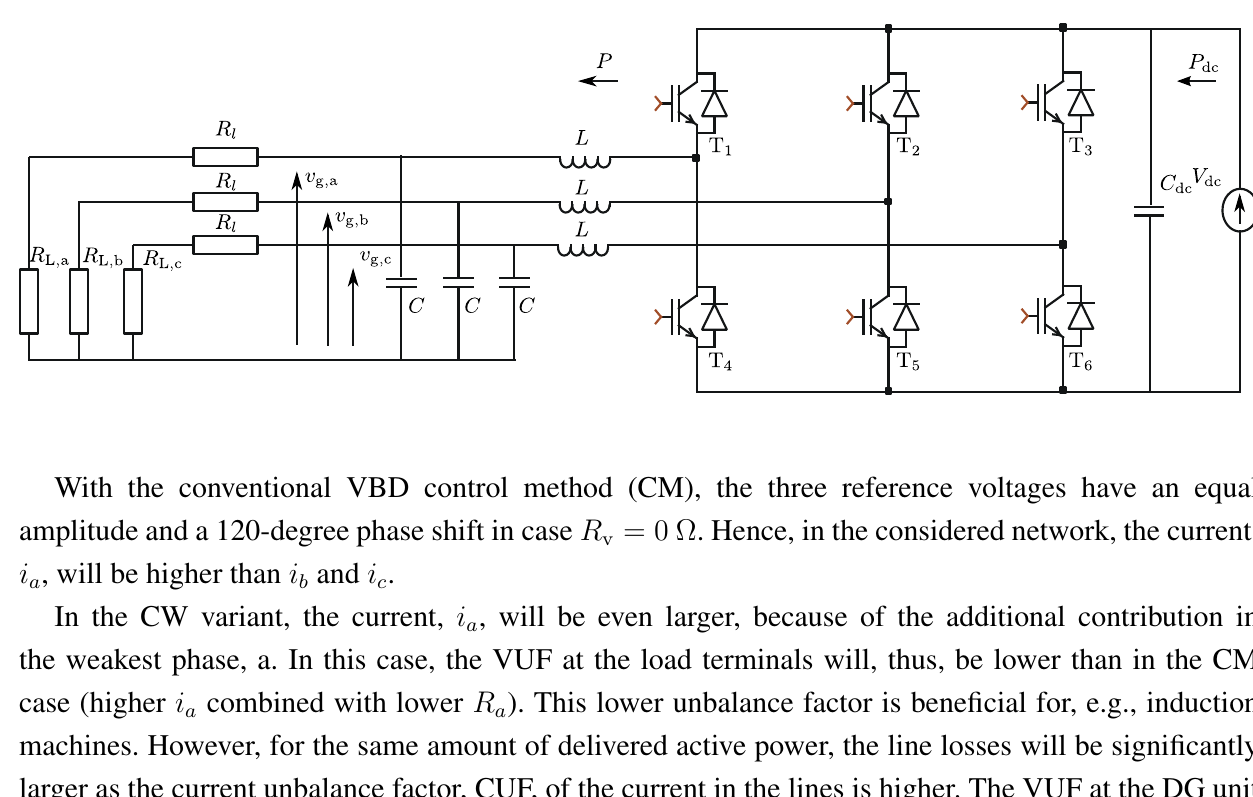
Figure 3. Islanded microgrid with three-phase